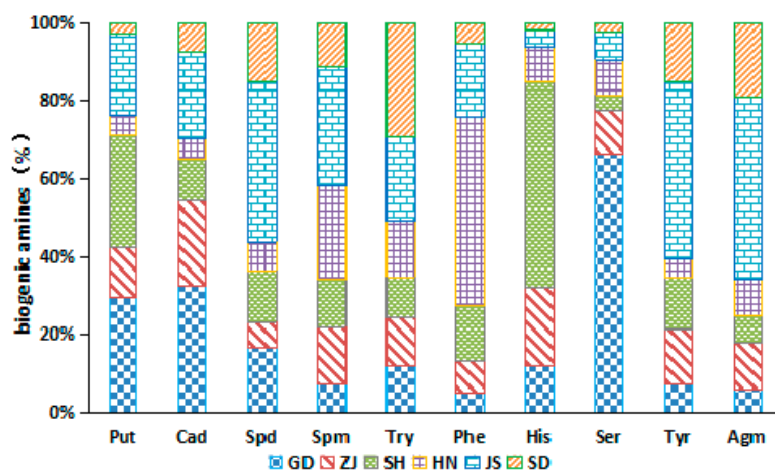
Figure 4. The average percentages of biogenic amines in Chinese soy sauce samples from different production regions.